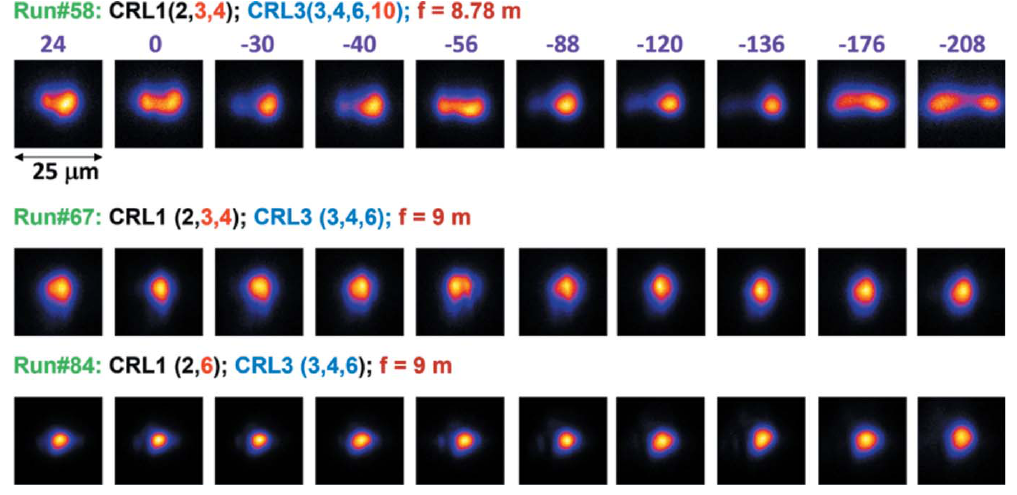
Figure 3 Sequences of LiF images measured along the XFEL beam propagation (with Z varied from Z = 24 mm to Z = (cid:2) 208 mm) for three runs with different configurations of CRL units.